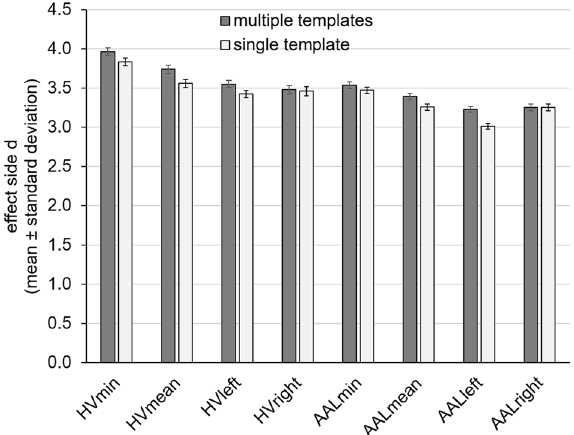
Fig. 3 Effect size d of the separation between normal and reduced putamen SBR. The effect size d characterizes the separation of the two Gaussians from the fit of the SBR histograms (mean deviation of the effect size estimates from histogram analysis of 1000 random subsamples each comprising 90% of the whole DAT-SPECT